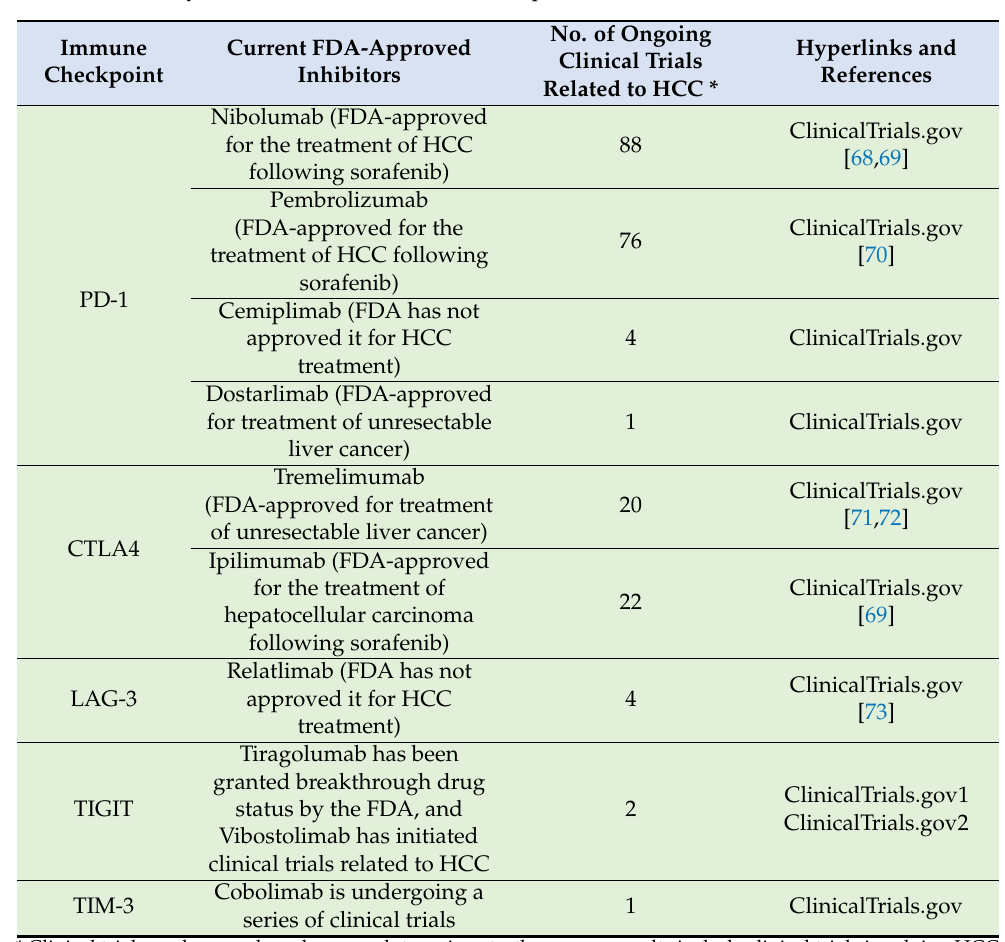
Figure 2. Immune checkpoint molecules and their ligands . Table 2. Summary of clinical trials of immune checkpoint inhibitors in